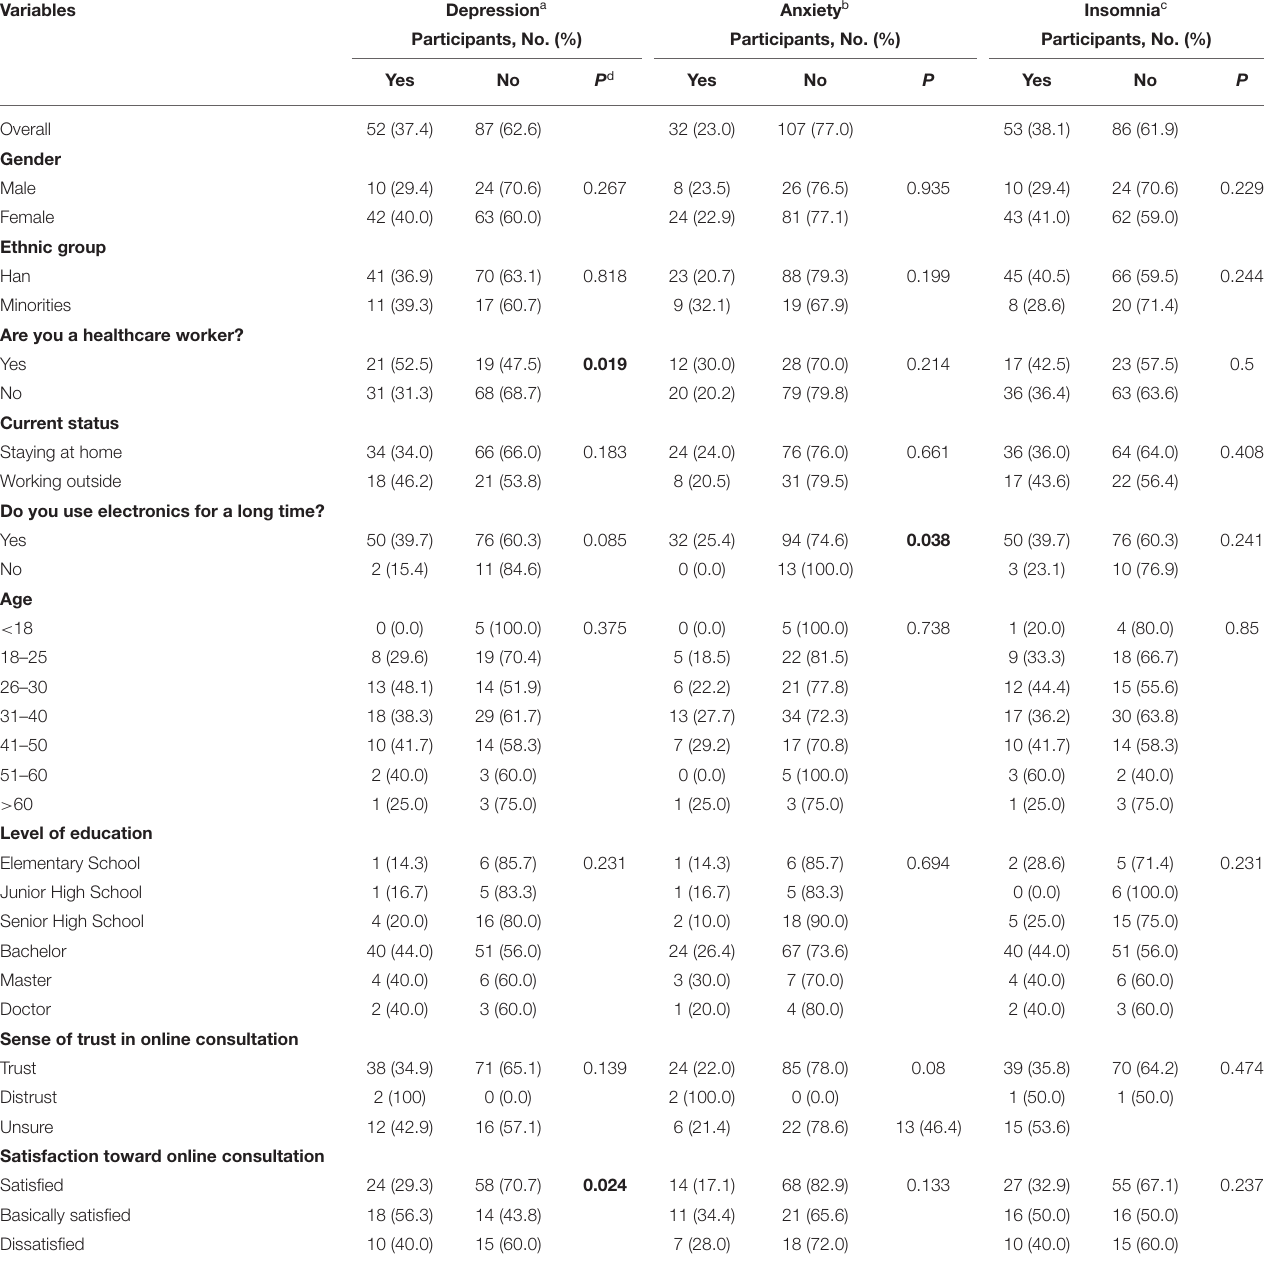
TABLE 3 | Socio-demographic differences between those with symptoms of depression, anxiety or Insomnia vs. those without depression, anxiety or insomnia. Variables Depression a Anxiety